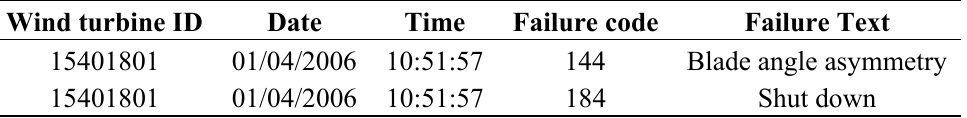
Table 4. Failure data.